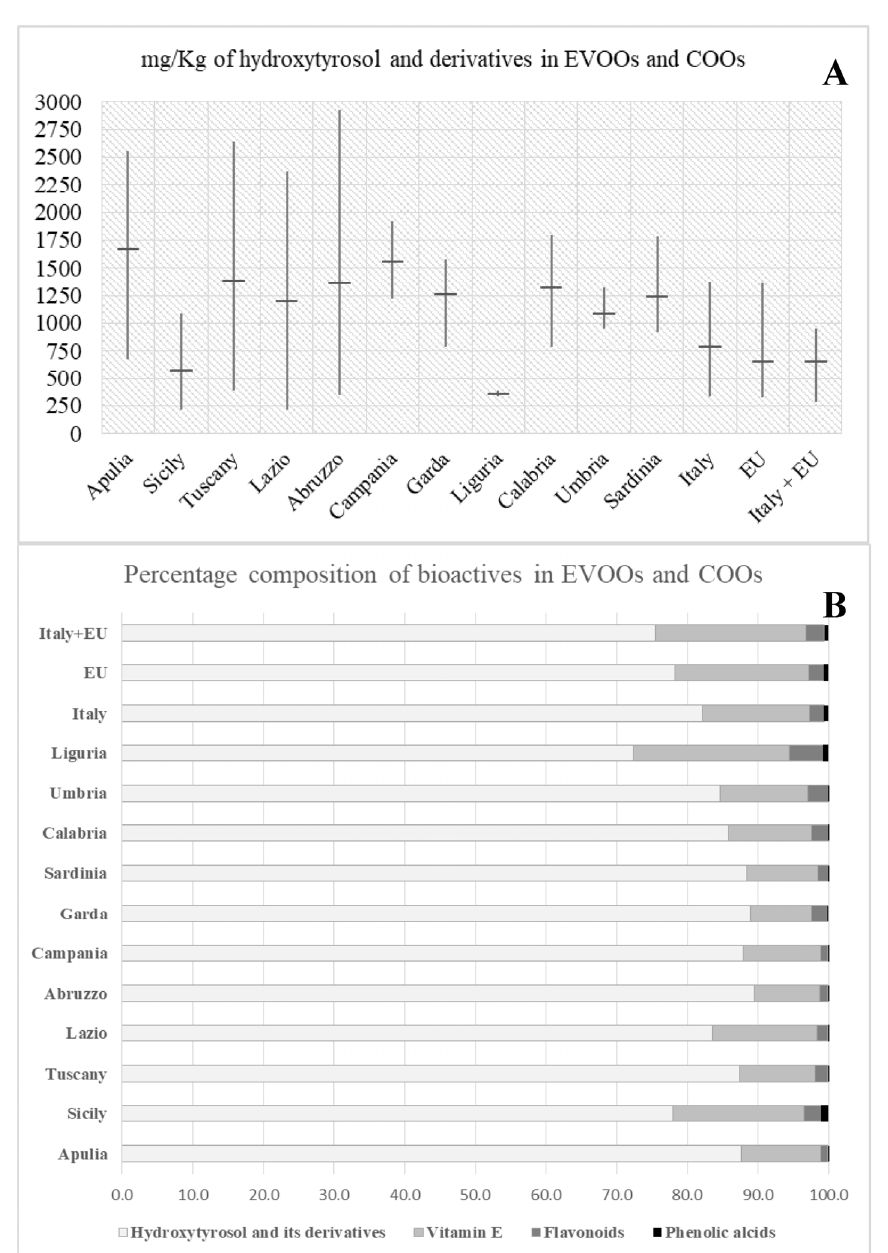
Figure 1. ( A ) mg kg − 1 of hydroxytyrosol and its derivatives in EVOOs and COOs; ( B ) relative percentage of four chemical groups in EVOO and COO samples. For sample descriptions see Table 1. For Sicilian samples, both COO and EVOO were put together.